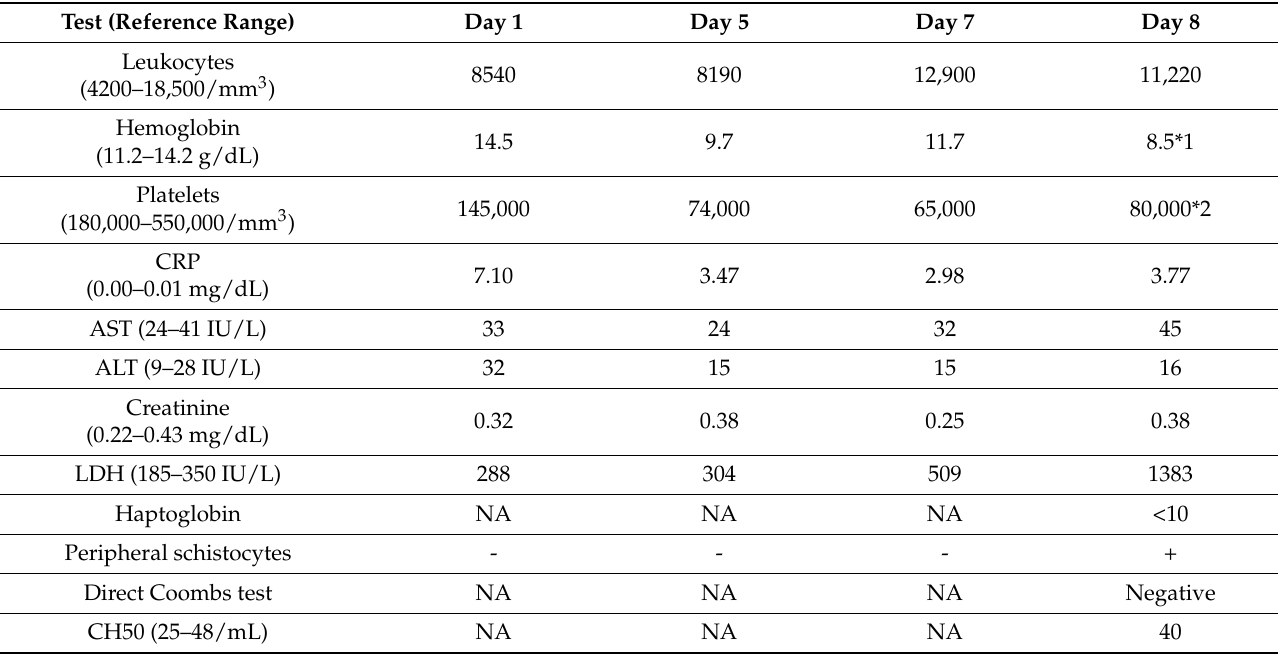
Table 2. Laboratory findings and blood pressure of the